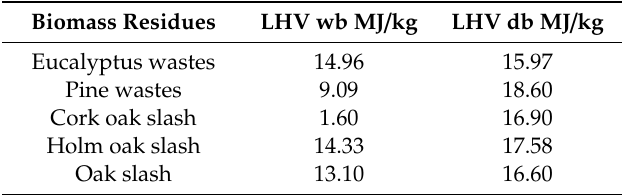
Table 5. Heating values of the residues under study. LHV wb = Lower heating value wet basis. LHV db = Lower heating value dry